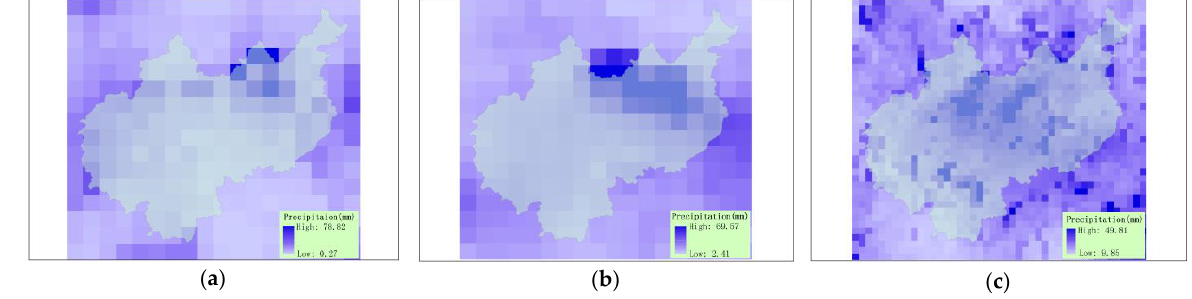
Figure 6. Spatial distributions of three sets of satellite precipitation data obtained for Oujiang River Basin on 16 July 2020. ( a ) GPM IMERGE Early; ( b ) GSMaP_NRT; ( c ) PERSIANN − CCS.